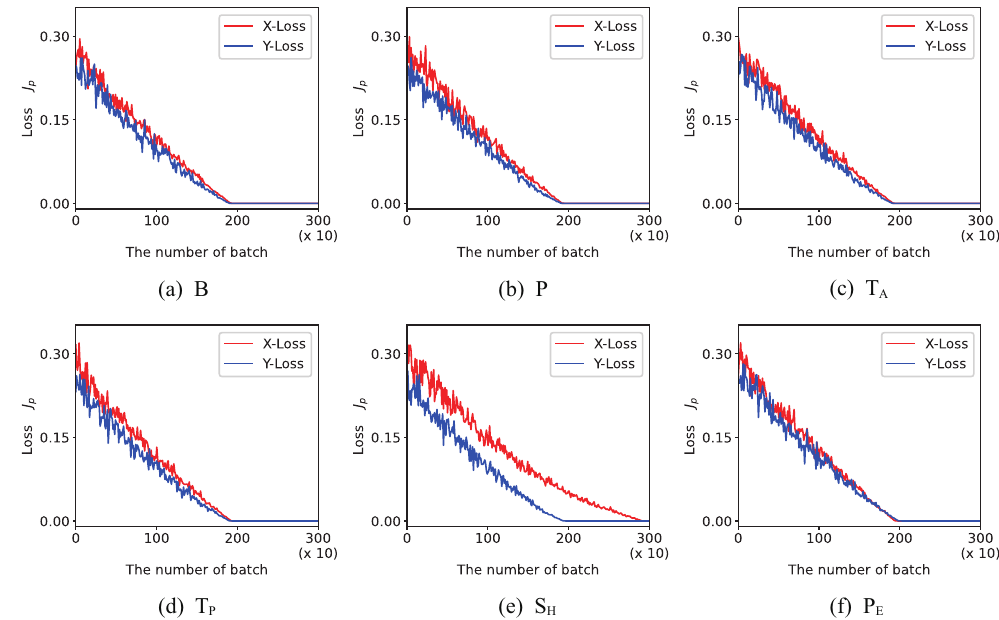
Figure 7. The Loss J p for different geometric distortions of star images captured from a different area of the sky randomly: ( a ) B (barrel), ( b ) P (pincushion), ( c ) T A (tangential), ( d ) T p (thin prism), ( e ) S H (shear) and ( f ) P E (perspective). The abscissa axis is the batch size, which is 128. The initial weights of different distortions were the